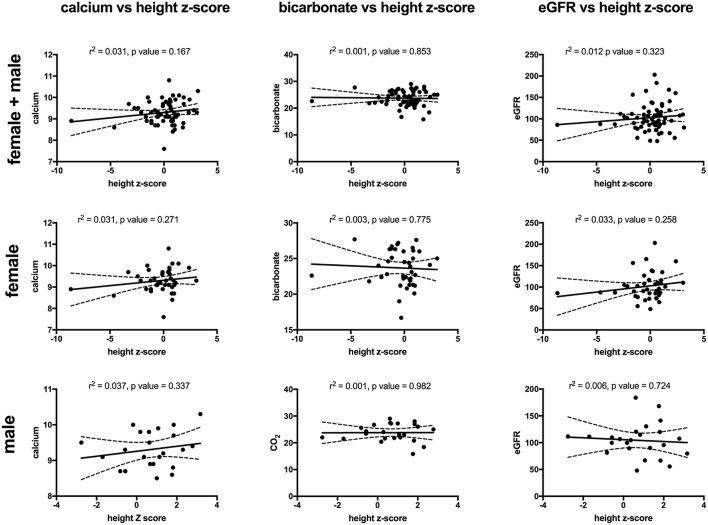
The correlations between height z-score with serum calcium (mg/dl) (left), serum bicarbonate (mEq/L) (middle), and eGFR (ml/min/1.73 m2) (right) for all patients (top), females (middle), and males (bottom). There was no significant correlation for any of the comparisons. Sixty-four patients (43 females and 24 males) had both a height z-score and serum calcium measured, 65 patients (41 females and 24 males) had both a height z-score and serum bicarbonate measured and 65 (41 females and 24 males) patients had both a height z-score and eGFR). Serum calcium in mg/dl, eGFR in mil/min/1.73 m2 and bicarbonate in mEq/L. The dashed lines represent 95% confidence intervals.